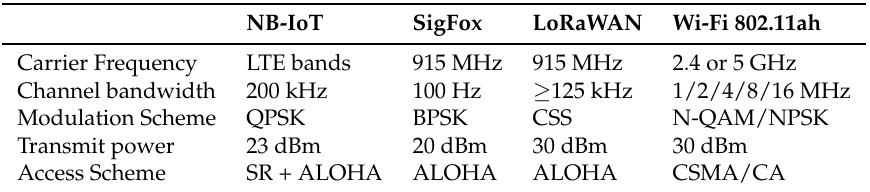
Table 1. Internet of Things (IoT) technologies